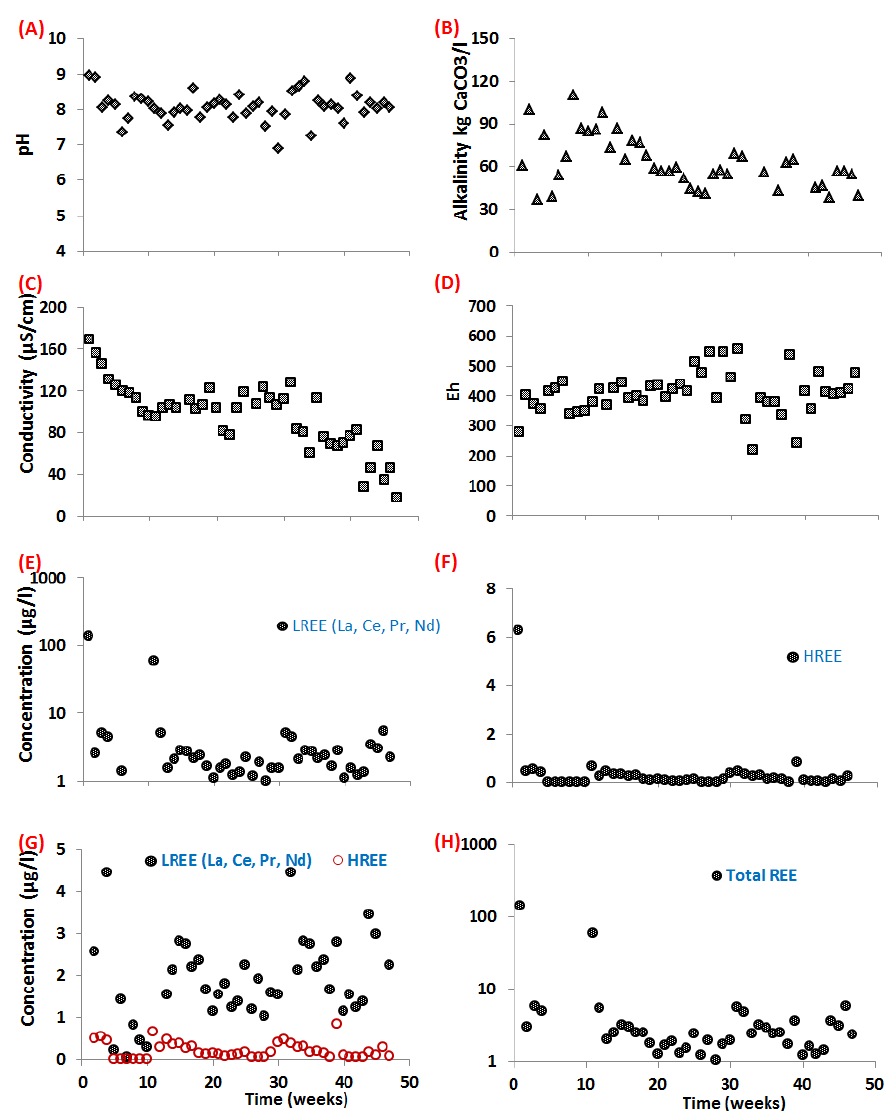
Figure 9. Weathering cell results corresponding to REE concentrate.